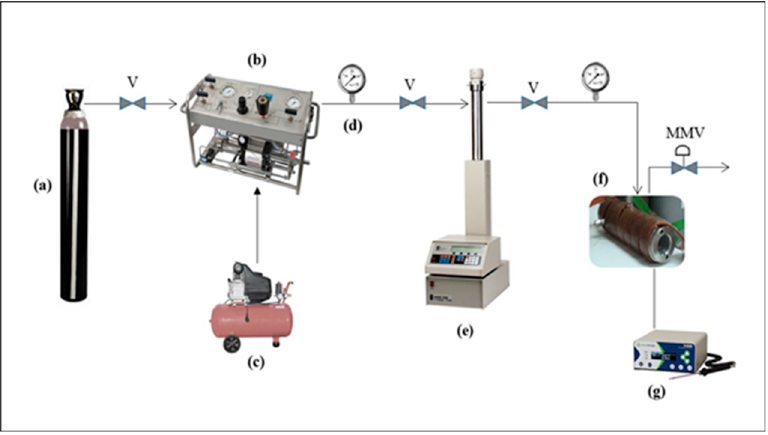
Figure 1. Outline of the experimental setup for the supercritical impregnation process: ( a ) Temperature controller; ( b ) High-pressure stainless steel impregnation cell; ( c ) Pressure transducer; ( d ) Syringe pump; ( e ) Air-driven pump; ( f ) Air compressor; ( g ) CO 2 reservoir, (V) Valves, (MMV) Micrometering valve.